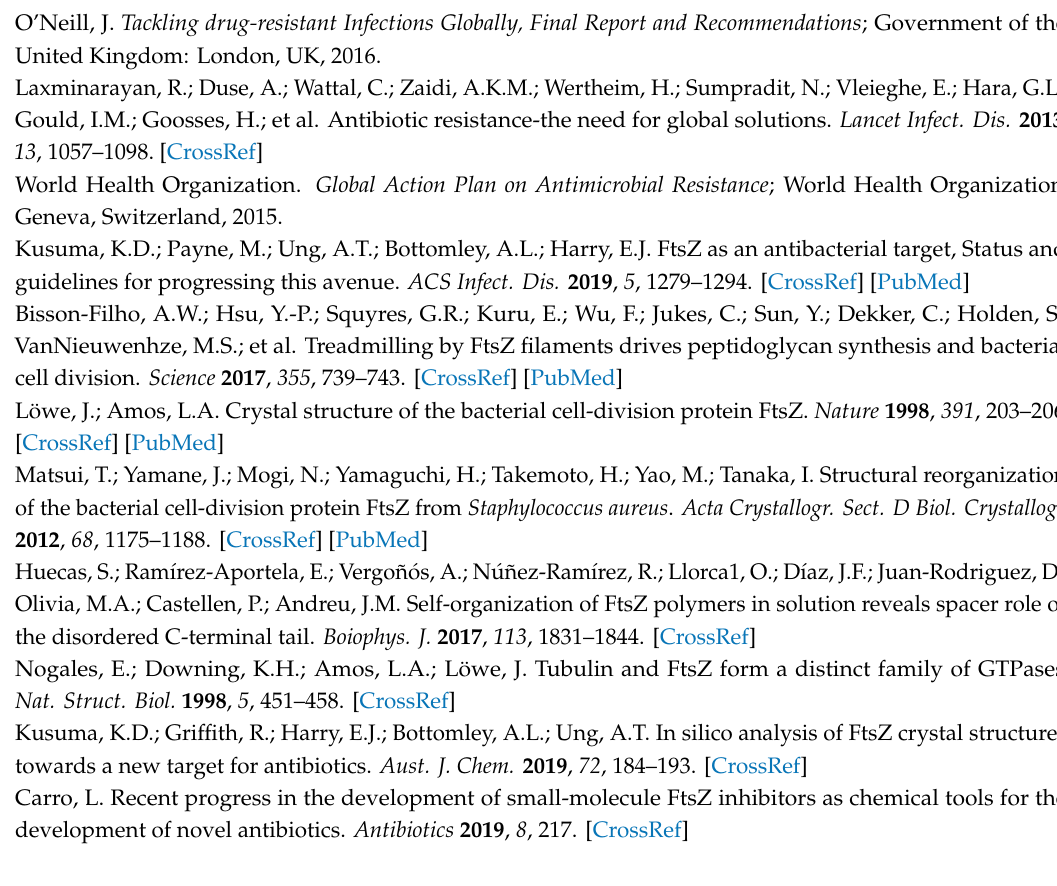
s1. Figure S1. The MST compounds synergizes with oxacillin to restore sensitivity in methicillin resistant Staphylococcus aureus. Figure S2. MST compounds were tested at 2 × and 4 × their inhibitory concentrations to determine phenotypic changes in MRSA. Figure S3. Purification of SaFtsZ. Figure S4. MST compounds are not cytotoxic to mammalian cells at concentrations of 2 × MIC. Figure S5. The MST compounds display no haemolytic activity. Figure S6. Caenorhabditis elegans nematodes (no treatment) viewed under the light microscope at time 0 h (left) and 72 h (right). Figure S7. The MST compounds did not display cytotoxicity in C. elegans nematodes up at 2 × their MIC values. Table S1: Antibacterial activity of the MST compounds on ESKAPE pathogens and other microorganisms tested in this study. Table S2. MRSA clone / isolate name, type, source, multi-locus, sequence type (MLST), staphylococcal cassette chromosome (SCCmec) type, clonal complex, Panton-Valentine leukocidin status (PVL) and spa type for isolates used in this study. Table S3. Criteria used for interpretation of the FICI obtained from checkerboard assays. Table S4. The FICI, calculated to three significant figures for each individual compound is tabulated